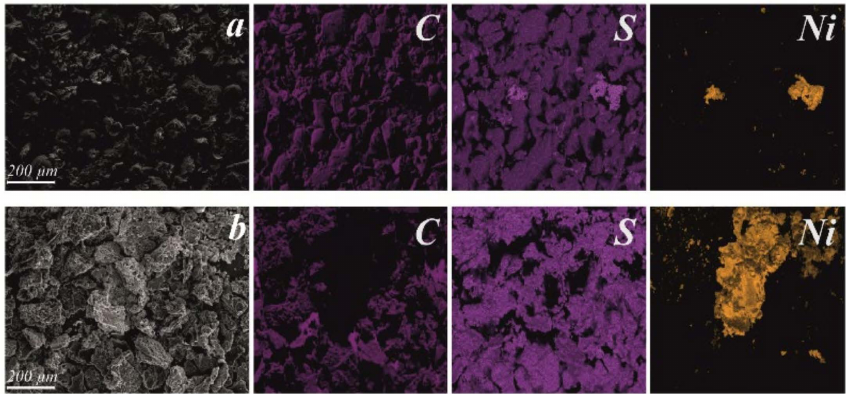
Figure 5. SEM images and elemental mapping from the surface of coke-containing catalysts: ( a ) C+T and ( b )